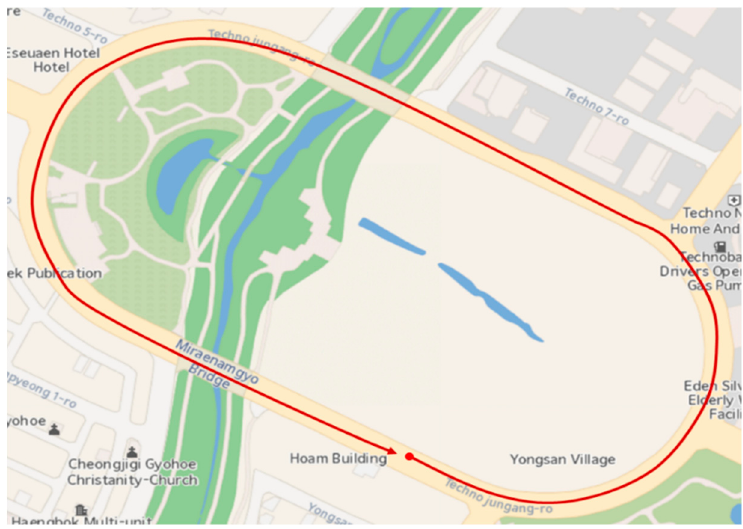
Figure 9. Vehicle’s reference trajectory in the experiment.